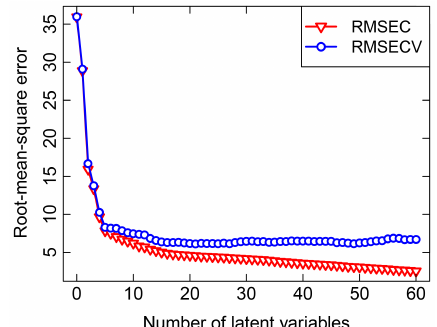
Figure 3. Illustration of RMSEC, which represents the fitting errors, and RMSECV, which represents the prediction error, calculated for TOR OC using the same calibration set. A 10-fold Venetian blinds CV was used for this